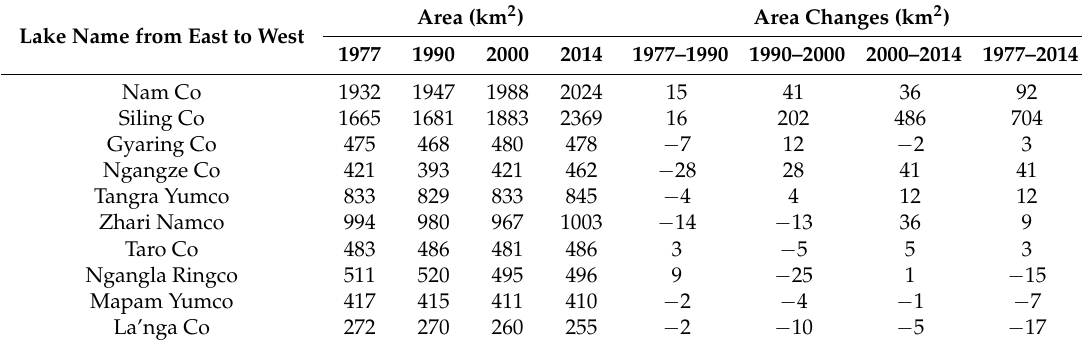
Table 3. Area changes of selected lakes along an east-west transect across the Gangdise Mountains.